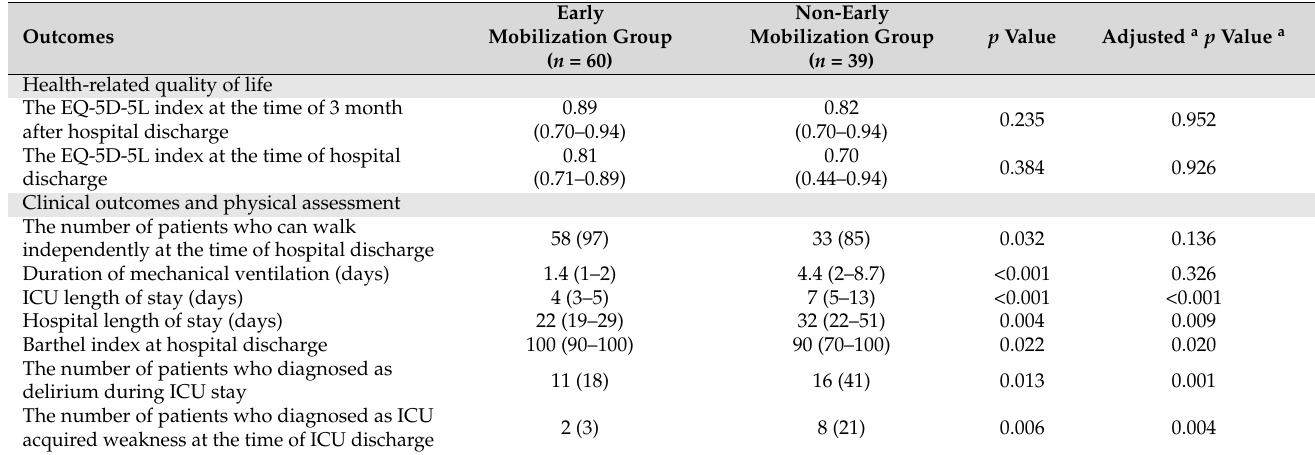
Table 4. Comparison of clinical outcomes between early mobilization group and non-early mobiliza- tion